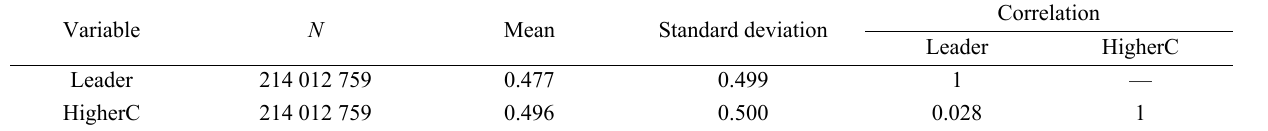
Table 5 Descriptive statistics of investors’ social network and trading time.